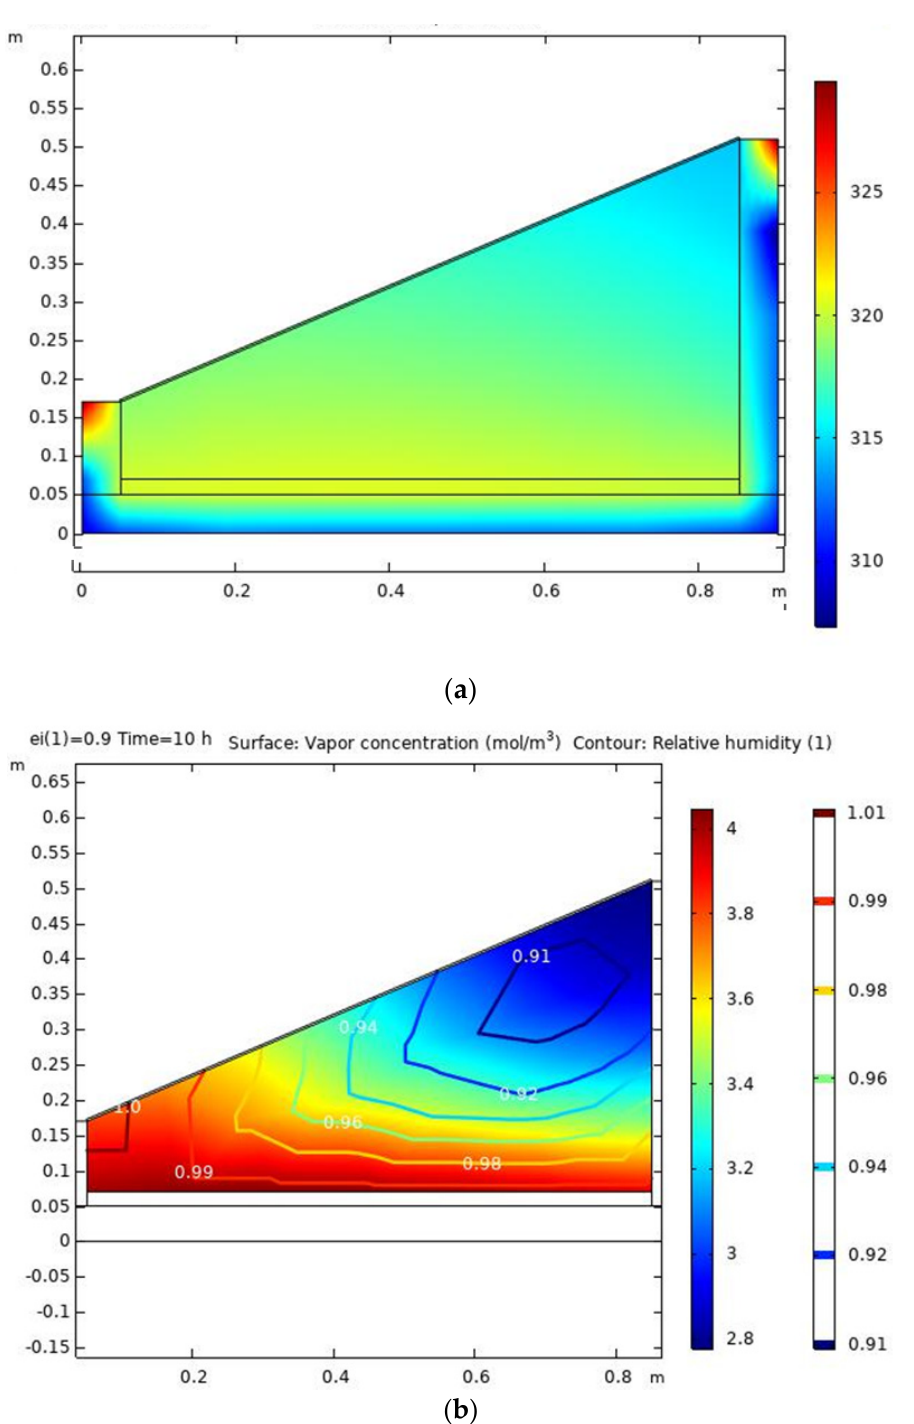
Figure 5. ( a ) Simulation results of temperature variation of the solar still (in K) (simulation time = 10 AM). ( b ) Simulation results of moisture concentration and relative humidity inside the solar desalination (simulation time = 10 AM).